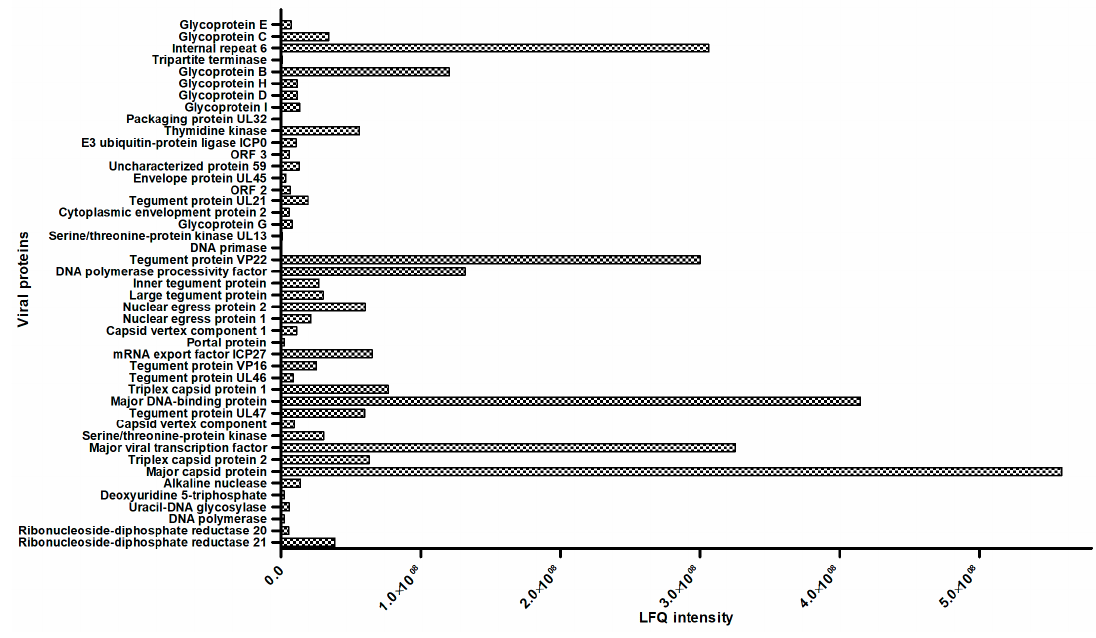
Figure 6. Quantification of viral proteins in EHV-1-infected PBMC at 24 hpi. Absolute quantification of viral proteins quantification in terms of LFQ values are given on the X-axis and the names of the viral proteins are given on the Y-axis; ( n = 4).